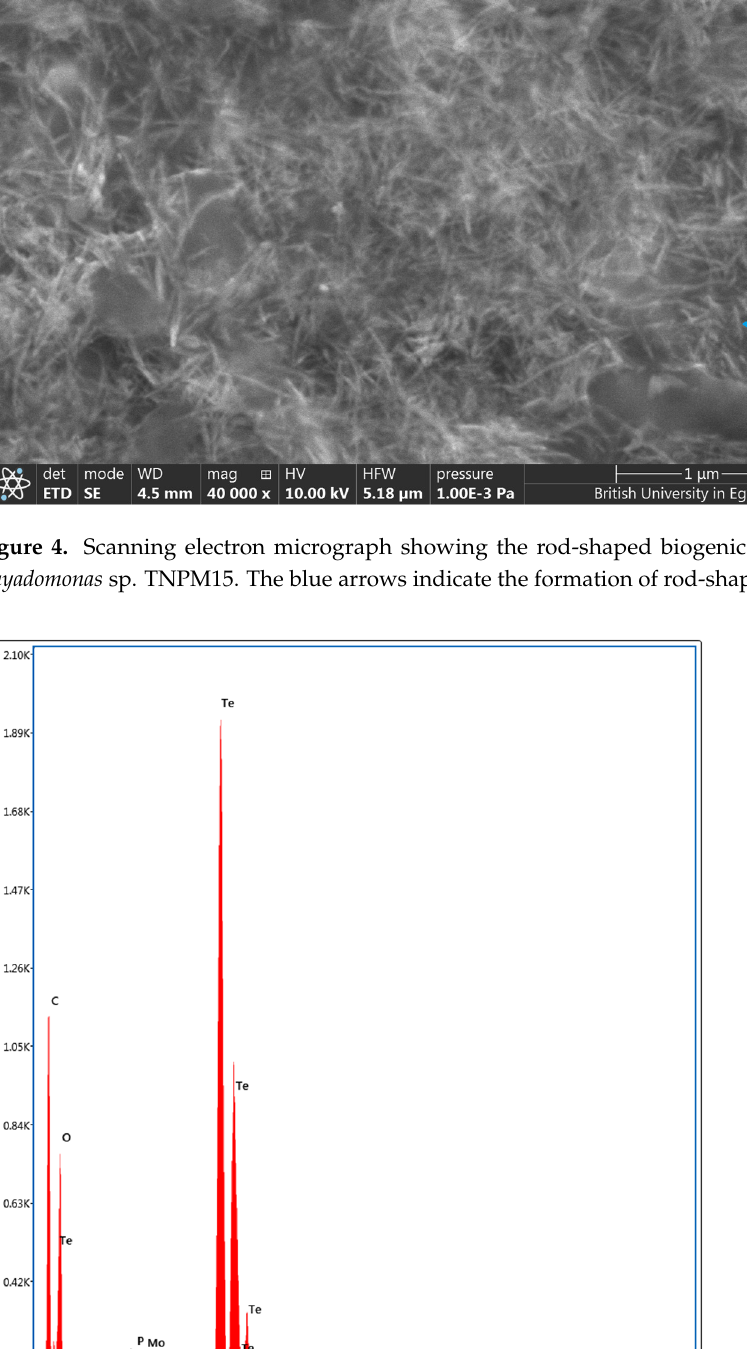
Figure 3. Transmission electron micrograph showing the rod-shaped biogenic TeNPs produced by Gayadomonas sp. TNPM15.